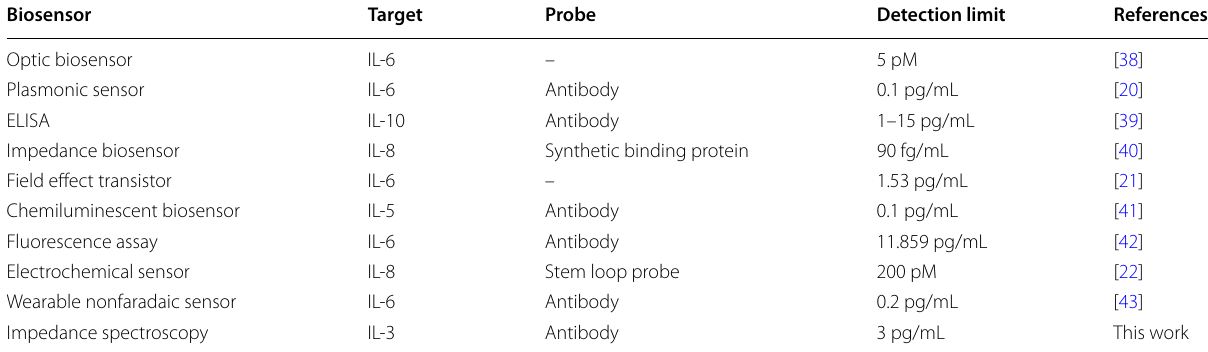
Table 1 Comparison among currently available sensing systems for